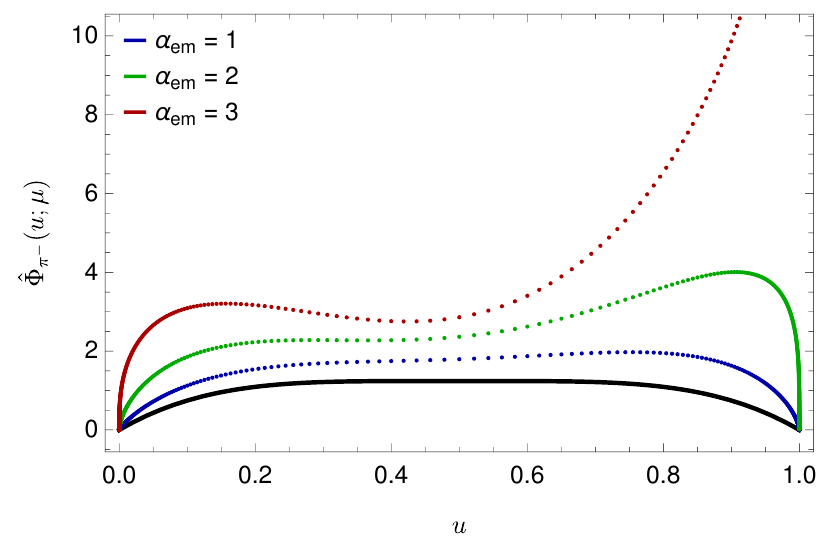
Figure 3 . Numerical solution to the RGE for the π − LCDA by discretization in u using N = 1001 logarithmically distributed points (see section 6 for more details). We model the LCDA by the QCD-only initial condition ˆΦ ( u ; µ ) = 6 u ¯ u (1 + a π ( µ ) C (3 / 2) (2 u − 1)) at the reference scale lat lat π − 2 2 ( µ ) given µ lat = 2 GeV (black solid curve), using the lattice value for the Gegenbauer moment a π lat 2 in table 1. The dotted curves show the function evolved to µ = 10 GeV for three fictitiously large values of α . The QED coupling is fixed, while α ( µ ) runs at one-loop. The following qualitative em s features induced by QED effects can be observed: first, the norm is no longer conserved. Second, the distribution becomes asymmetric and favours the up quark, which carries a larger fraction of the pion momentum due to its larger electromagnetic coupling. Third, the endpoint behaviour gets modified, and above a certain threshold the LCDA starts to